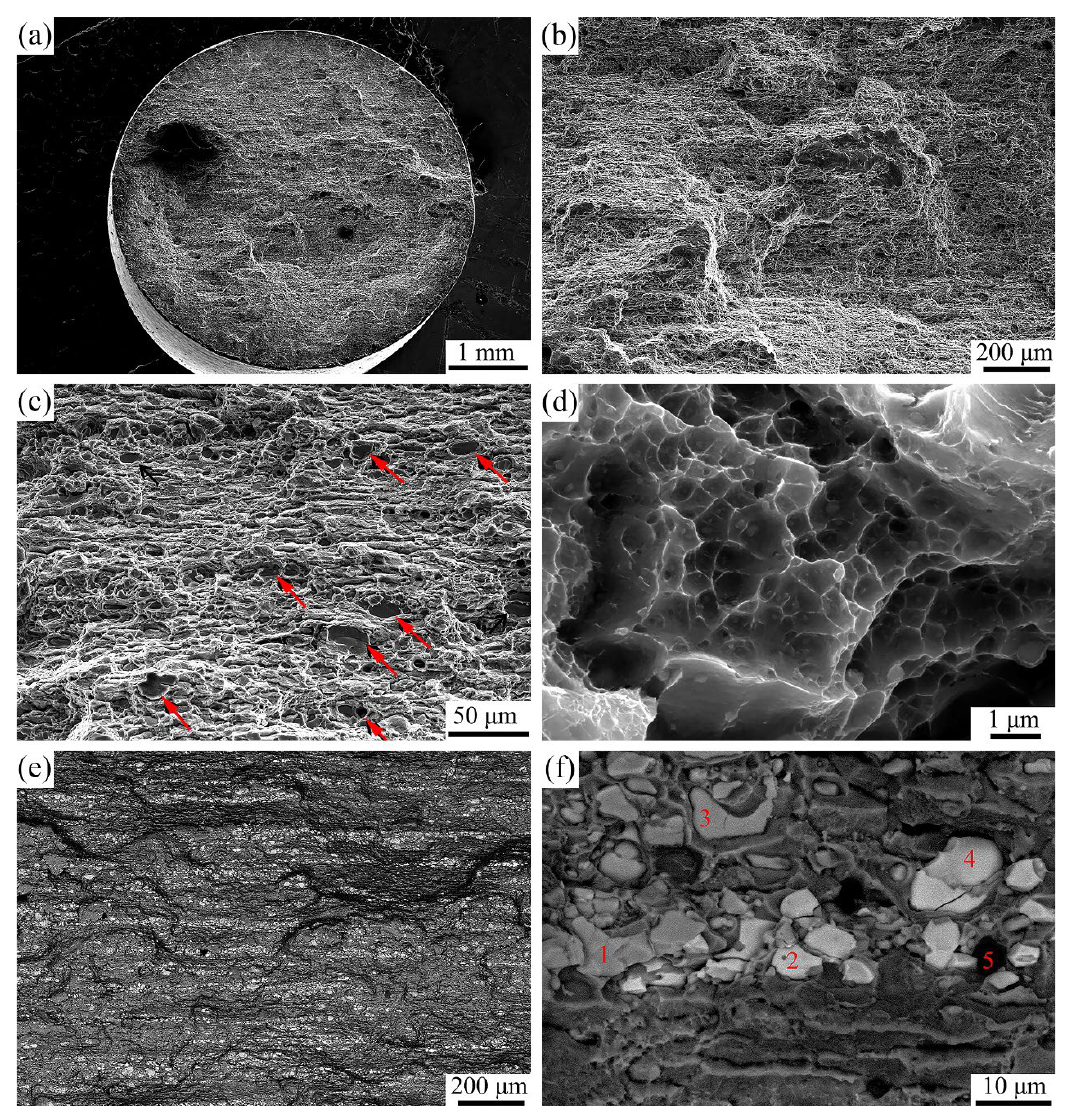
Figure 5. Fractography of a tensile specimen. ( a – d ) Second electron (SE) micrographs, ( e – f ) BSE mi- crographs. (The red arrows in ( c ) are dimples, the numbers 1–5 in ( f ) refer to different second phases).